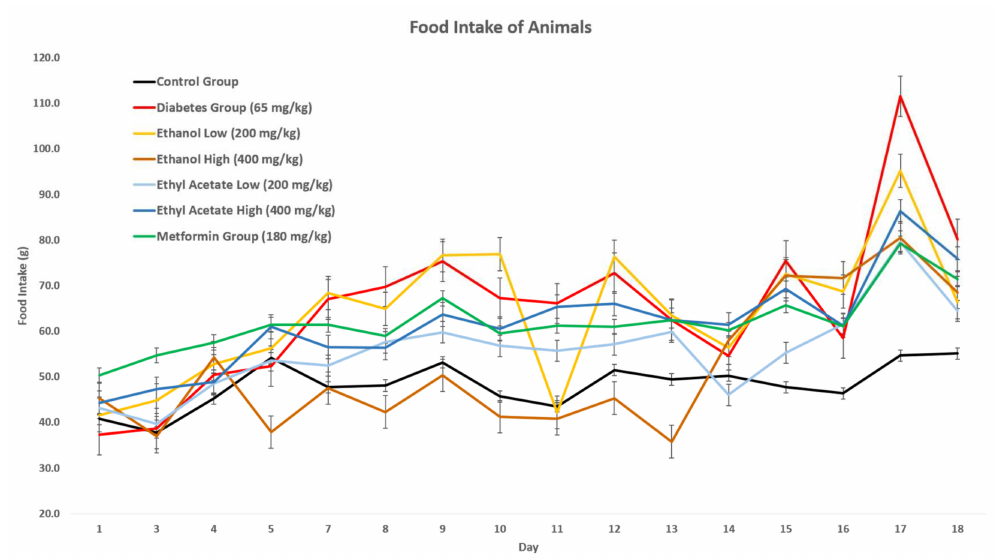
Figure 2. Effect of food intake on P. tetrastromatica extract-treated